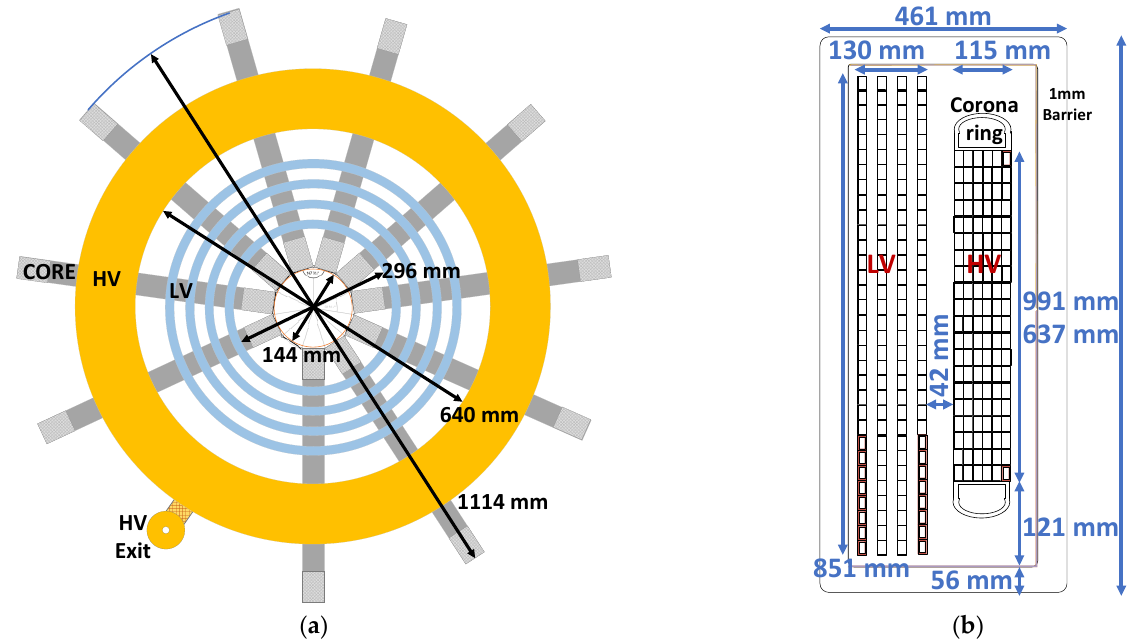
Figure 3. Dimensions of the real scale Ferrite 10 MW, 1.8/18 kV, 0.32 T, 5555/555 A, 12/120 Turns, 5 kHz MFT: ( a ) Top view; ( b ) Side view.